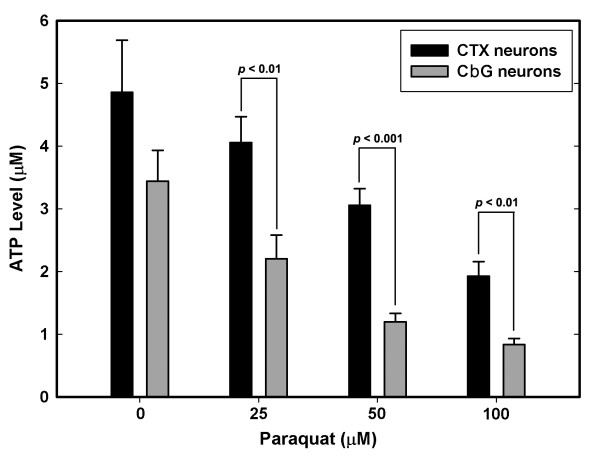
Differential levels of ATP and the effect of paraquat on these levels in CTX and CbG neurons. Data represent the mean (± SEM) of ATP levels from 8 experiments. The P values for the indicated comparisons (t-test) are shown.